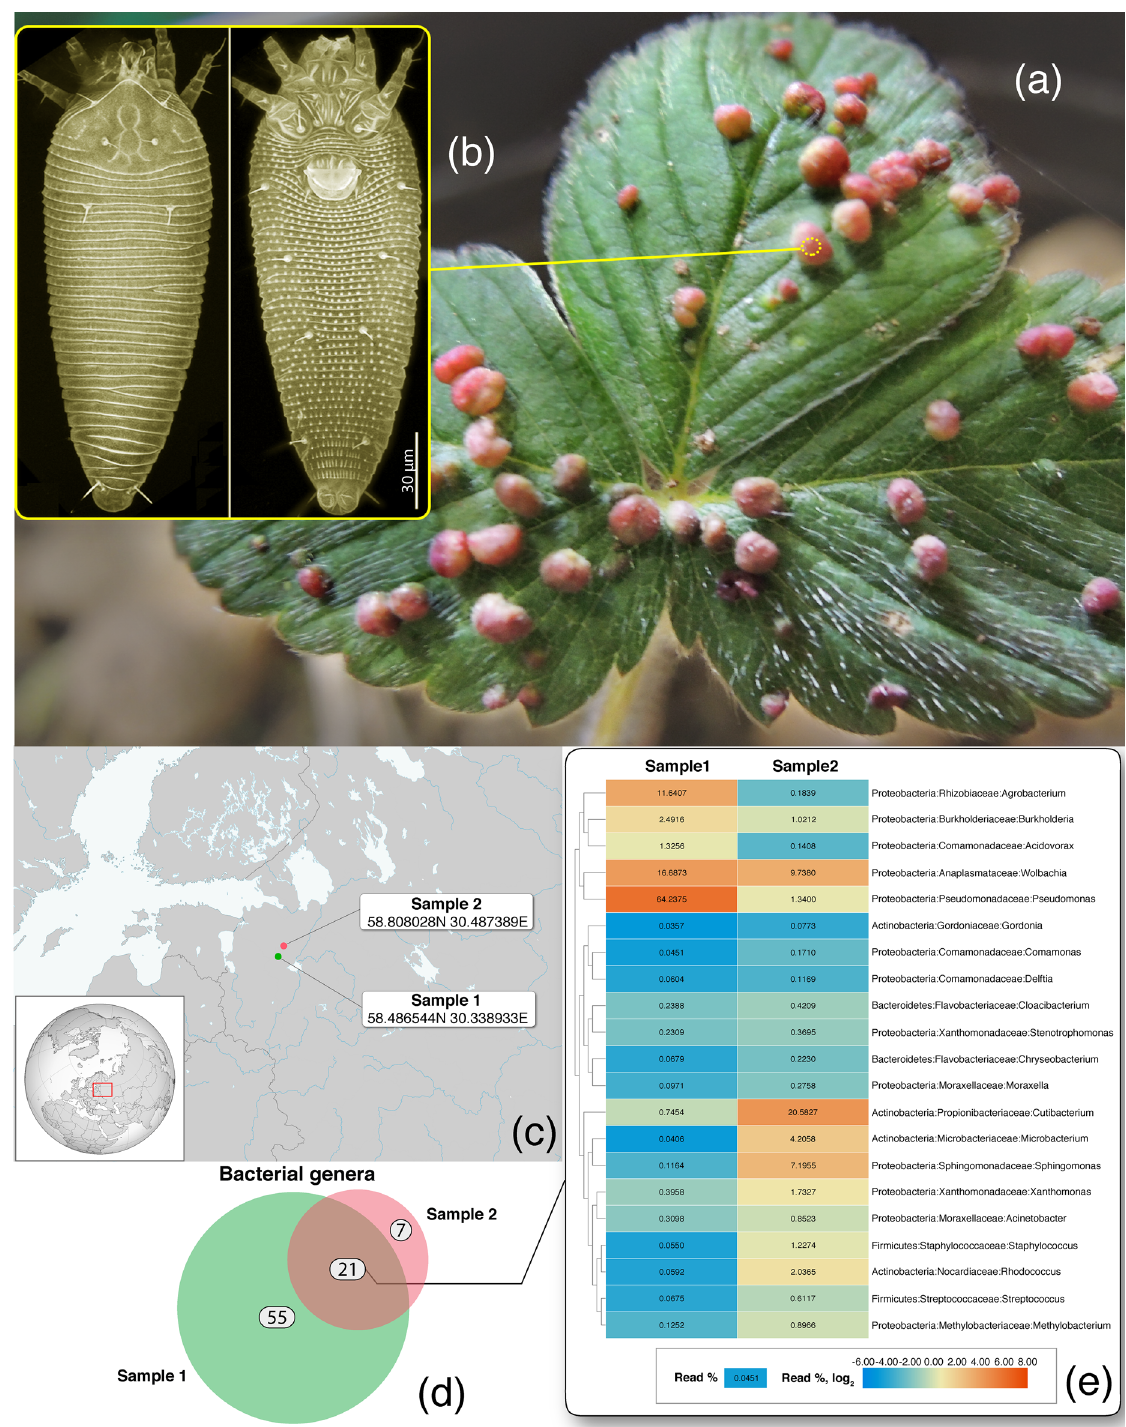
Figure 1. Galls on leaves of the creamy strawberry Fragaria viridis ( a ) induced by the mite Fragariocoptes setiger ( b ); mite collection localities, samples 1 and 2 ( c ); Bacterial taxonomic richness in samples 1 and 2, the number of unique bacterial genera in each sample and in their intersection is shown as a Venn diagram ( d ), k-mer-based taxonomic classification was done in Kraken using a normalized abundance threshold of ≥ 0.0338%; there was a total of 49,514,852 and 3,830,185 classified bacterial reads in samples 1 and 2, respectively; detailed taxonomic classification and abundance estimates are given in Supplementary Table S2 and visualized in Supplementary Fig. S1; abundance of bacterial genera in the intersection of samples 1 and 2 ( e ), abundance values are percentages of classified reads, while the heatmap colors are based on log 2 -transformed abundance values. Maps were generated by modifying public domain maps in Adobe Illustrator CS6 (https:// commo ns. wikim edia. org/ wiki/ File: Outli ne_ Map_ of_ North weste rn_ Feder al_ Distr ict. svg, Finland (orthographic